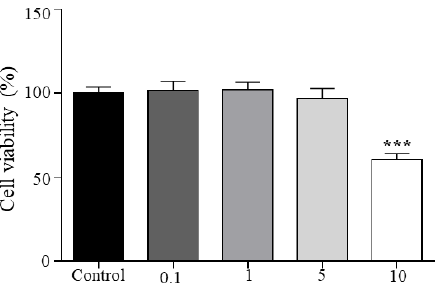
Figure 1. Cell viability of adipocytes treated with ascending concentrations (0.1, 1, 5, and 10 µg/mL) of L. alba carvone chemotype essential oil (EO) measured by MTT. Values are mean ± SEM. *** p < 0.001 vs. control (not treated with